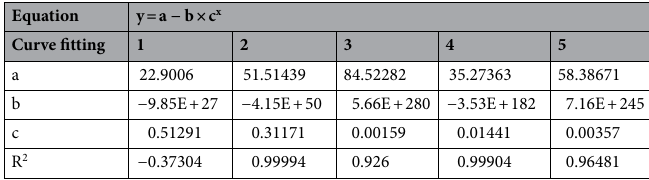
Table 4. Predictive model and parameters.